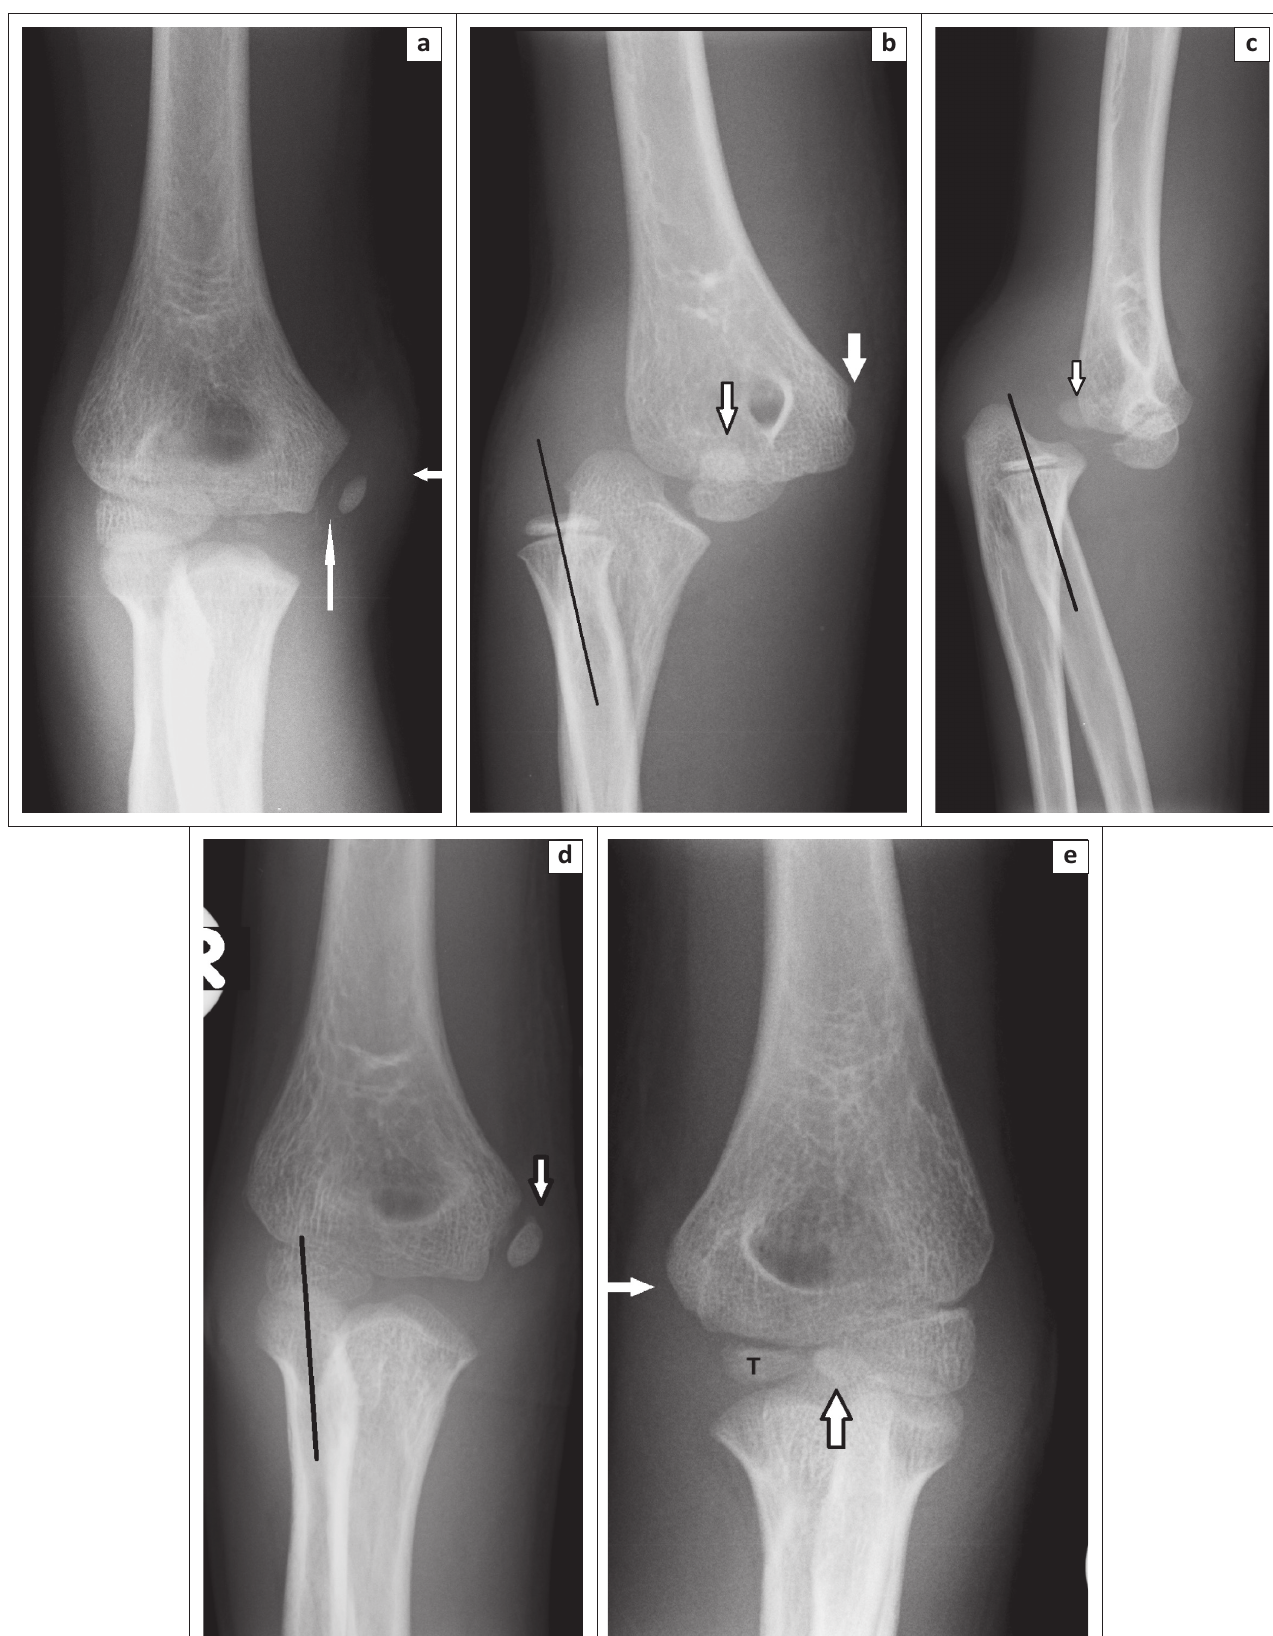
FIGURE 11: (a) Right medial epicondyle fracture (long arrow) with minimal displacement treated conservatively. Note the striking medial soft tissue swelling (short arrow). (b) AP and (c) lateral projections of a six-year-old. The radiocapitellar line is broken (black line), in keeping with dislocation. Medial soft tissue swelling and absence of the normal medial epicondyle (white arrow) in a child of this age should prompt careful evaluation for an entrapped epicondyle within the joint (white and black arrow). (d) Post reduction image of the same child as (a and b), showing radiocapitellar alignment (black line) and relocated medial epicondyle (black arrow). (e) AP of right elbow in a nine-year-old – the ossification centre of the trochlea is normally positioned (T); the medial epicondyle is not seen (short arrow) as it lies trapped within the joint (white and black